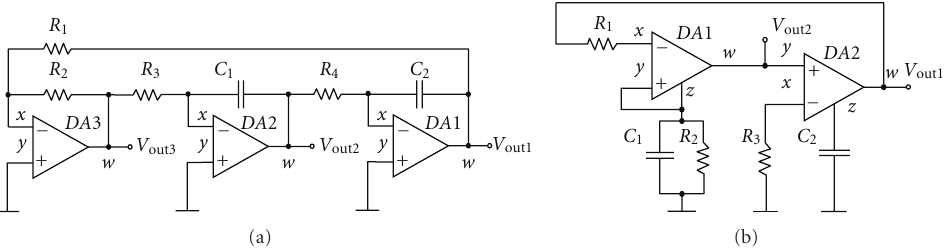
Figure 5: Oscillation systems of two integrators with CFOA: (a) classical and (b) new